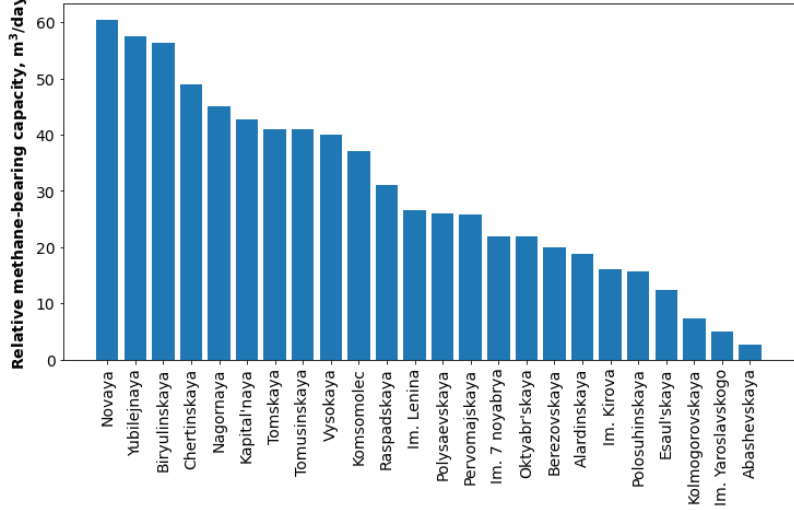
Figure 2. Relative methane-bearing capacity of the Kuzbass coal mines [23].